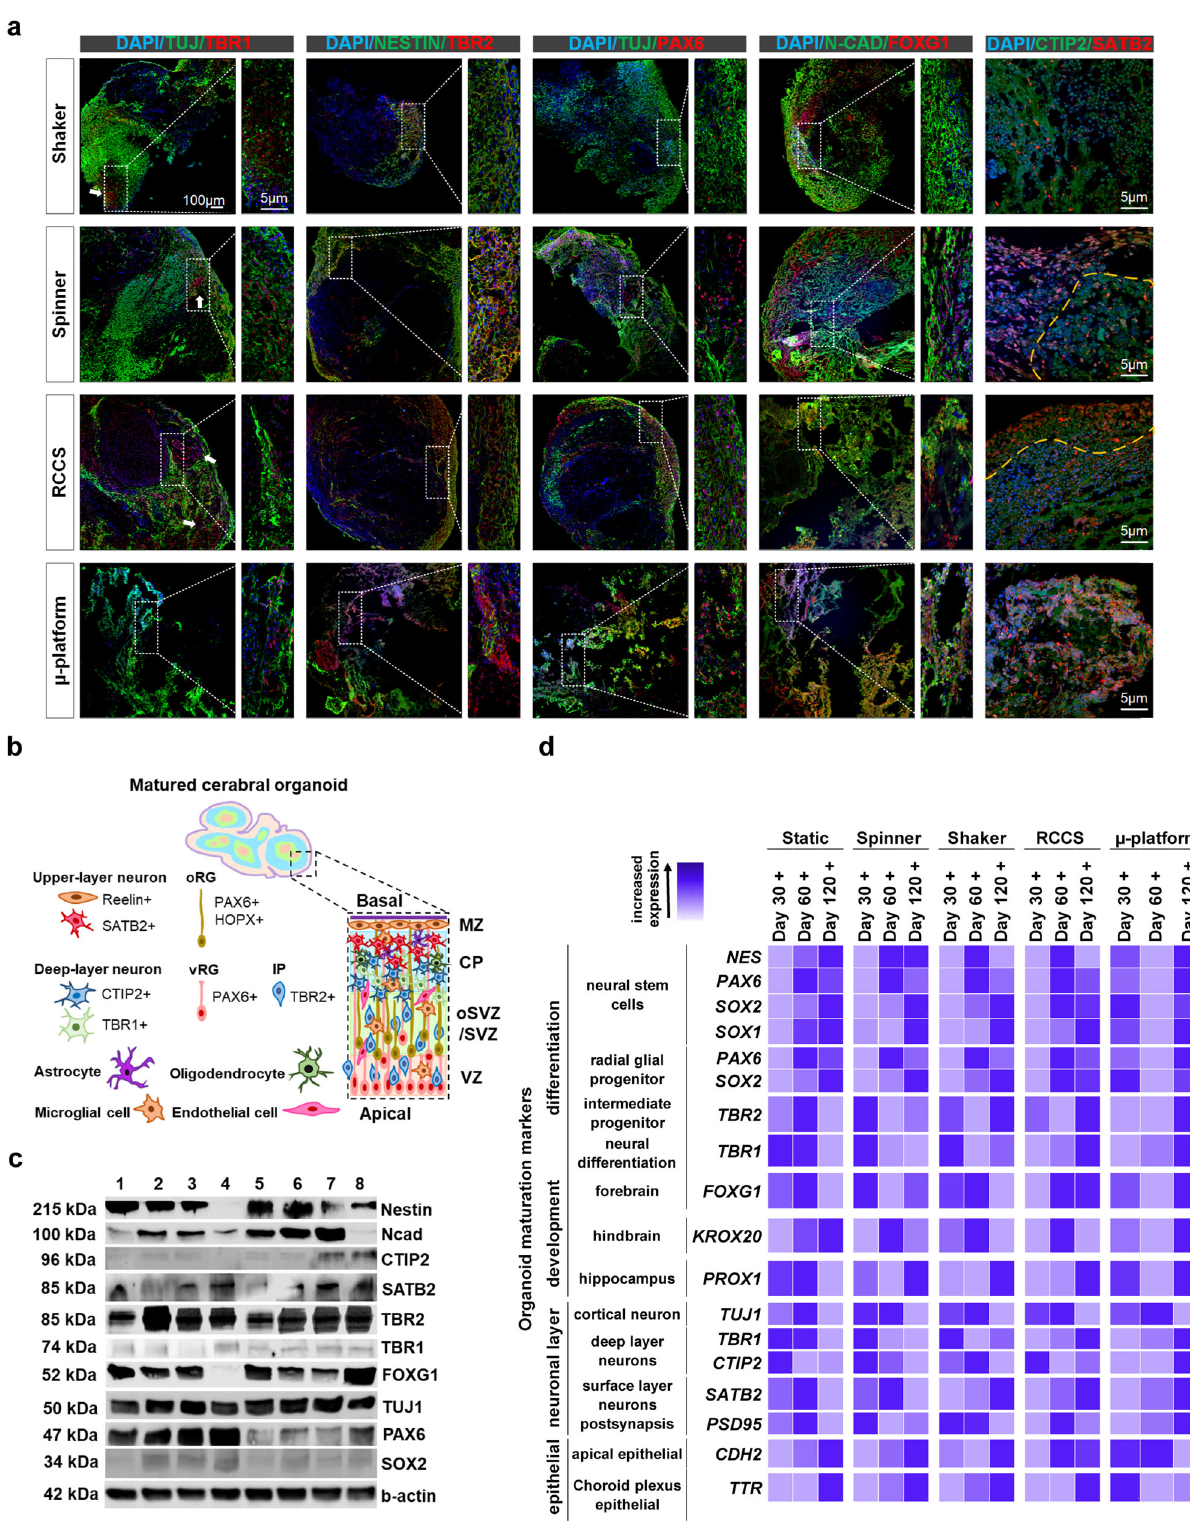
Supplementary Fig. 2b, Supplementary Fig. 3, Supplementary Table 1), and all dynamic systems at day 120 (Fig. 4). Moreover, the co-localization of nestin and intermediate progenitor cell marker, (T-box brain protein 2) TBR2 indicate that the cerebral organoids possessed well-de fi ned progenitor zone organization and neural identity 58 for all dynamic systems at day 120 but mostly in µ-platform and RCCS (Fig. 4a – c,